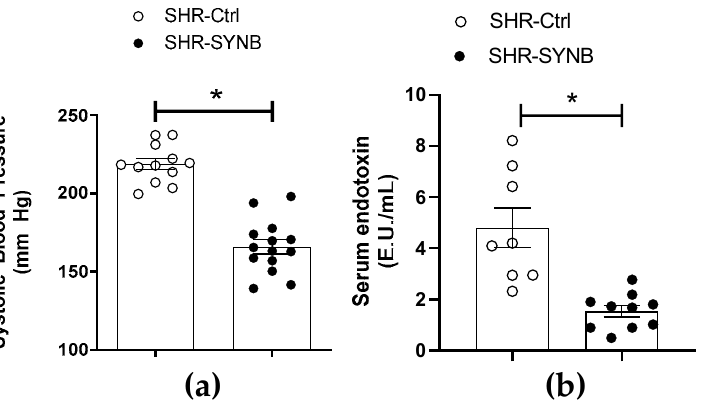
Figure 1. ( a ) Effect of supplementation with Prodefen ® on systolic blood pressure. Results (Mean ± S.E.M.) are expressed in mm Hg. n = 12–14 animals each group. * p < 0.05 (Student’s t -test). ( b ) Serum endotoxin levels in SHR-Ctrl and SHR-SYNB. Results (Mean ± S.E.M.) are expressed in Endotoxin units (E.U.)/mL. n = 8–10 animals each group. * p < 0.05 (Student’s t -test).